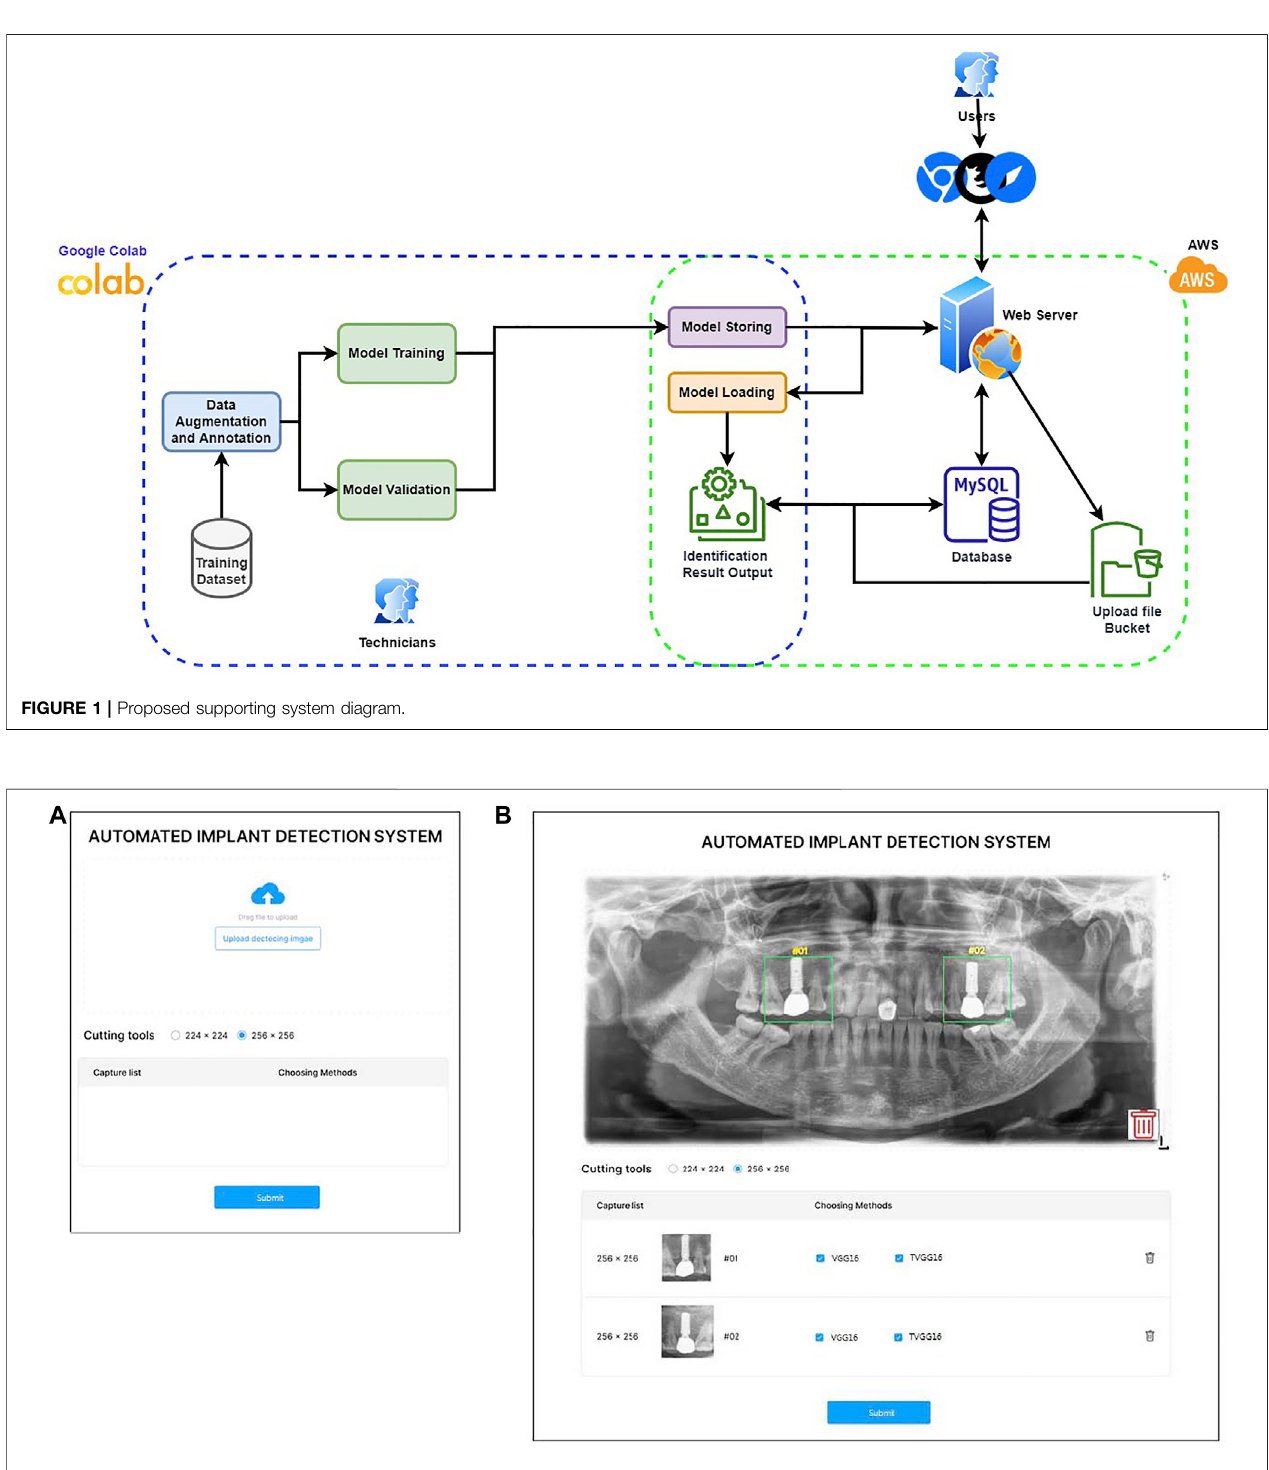
Frontiers in Pharmacology |